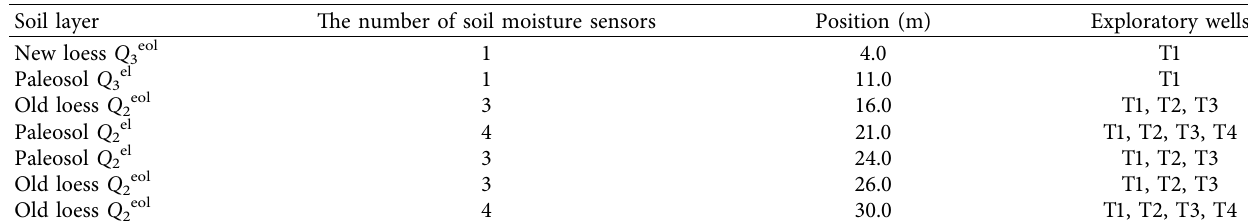
Table 2: Layout of soil moisture